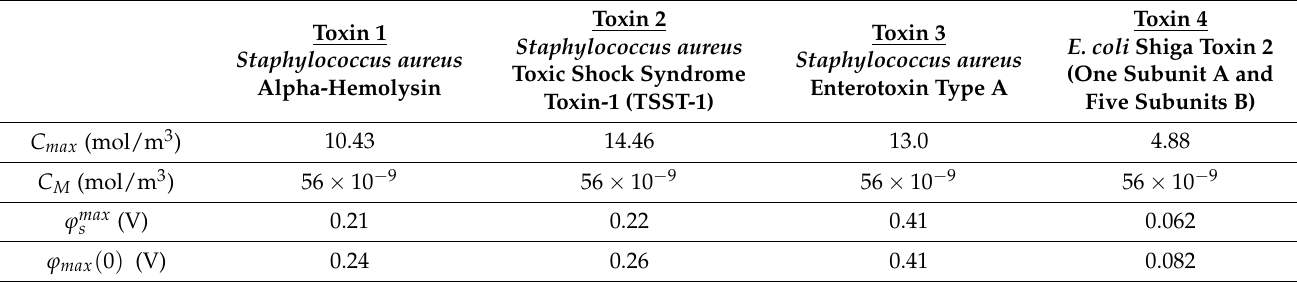
Table 3. Calculation of ϕ max s (the potential at the outer Helmholtz plane (OHP) when the concentration on it is C max ) and ϕ max ( 0 ) (the corresponding potential applied to one side of the duct) per toxin. C max : the maximum concentration that can be achieved due to steric effects and C M : the toxin concentration at the middle of the duct after the electric potential